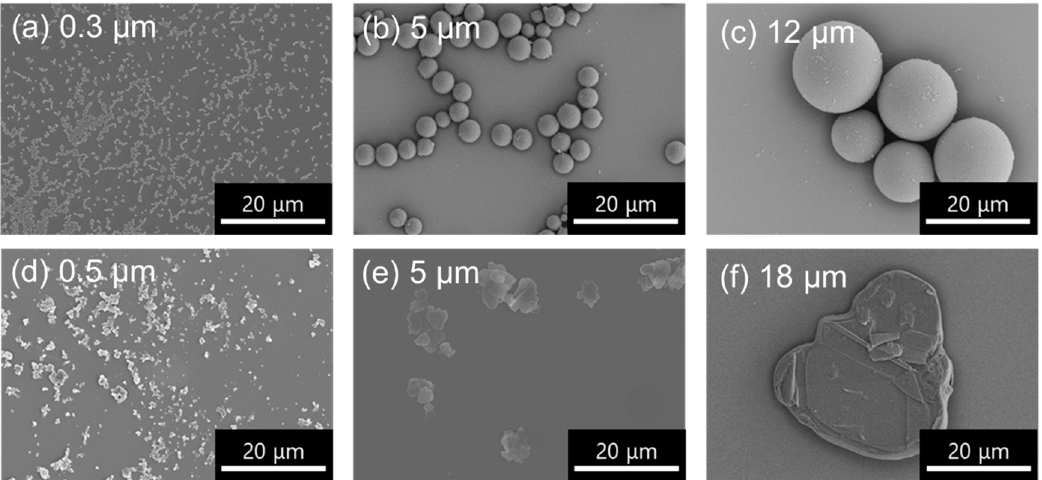
Nanomaterials 2020 , 10 of ( a ) 0.3, ( b ) 5, and ( c ) 12 µm, and hBN sheets with different sizes of ( d ) 0.5, ( e ) 5, and ( f ) 18 µm were used.